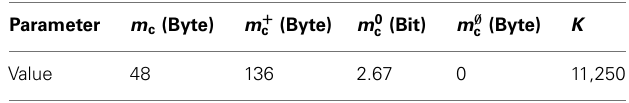
Table 1 | Parameters used to instantiate the memory model (2) on K and